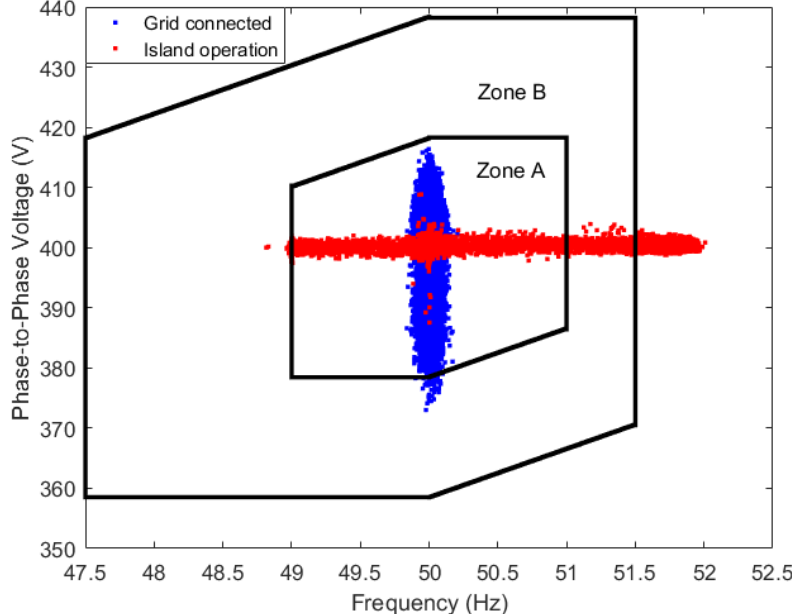
Figure 9. 10 min average values of the phase-to-phase voltage with the corresponding frequency for islanded operation and grid operation with IEC Standard 60034-1 Zone A and Zone B plotted.